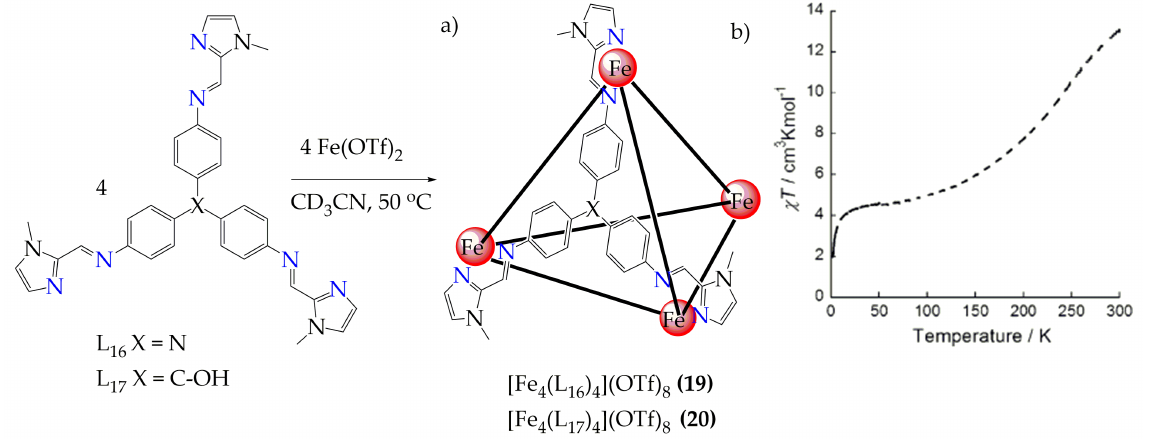
Figure 14. ( a ) Representation of the molecular structure of tetrahedral cage complexes of 19 and 20. ( b ) Temperature dependence of χ T of 26 , between 300–2 K. Reproduced with permission from [98]; Published by Wiley,